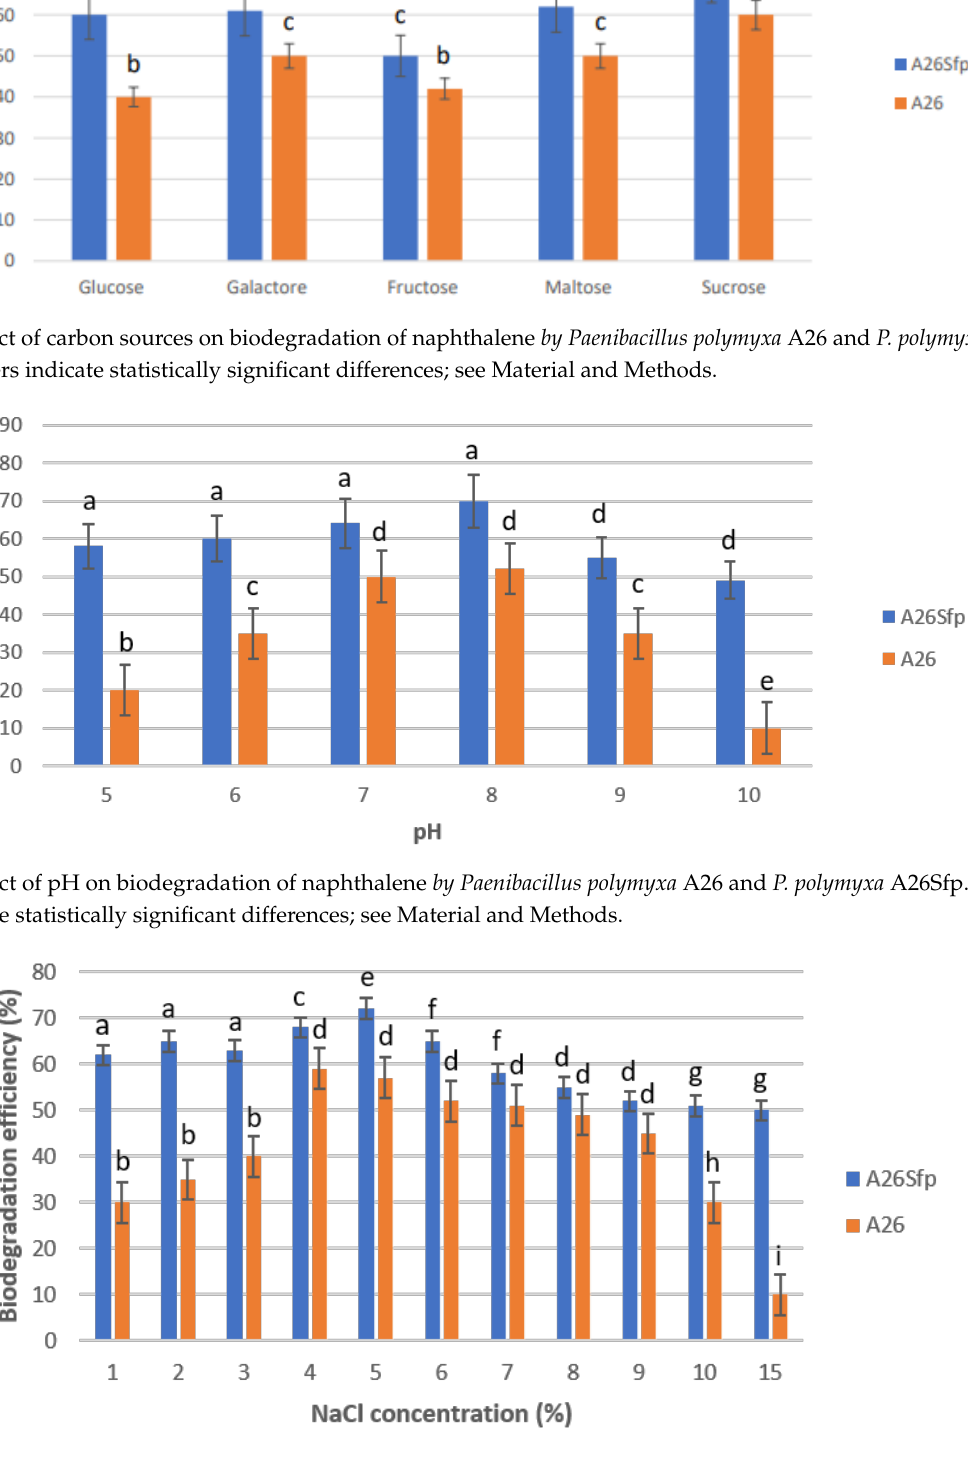
Figure 5. Effect of salinity on biodegradation of naphthalene by Paenibacillus polymyxa A26 and P. polymyxa A26Sfp. Different letters indicate statistically significant differences; see Material and Methods.